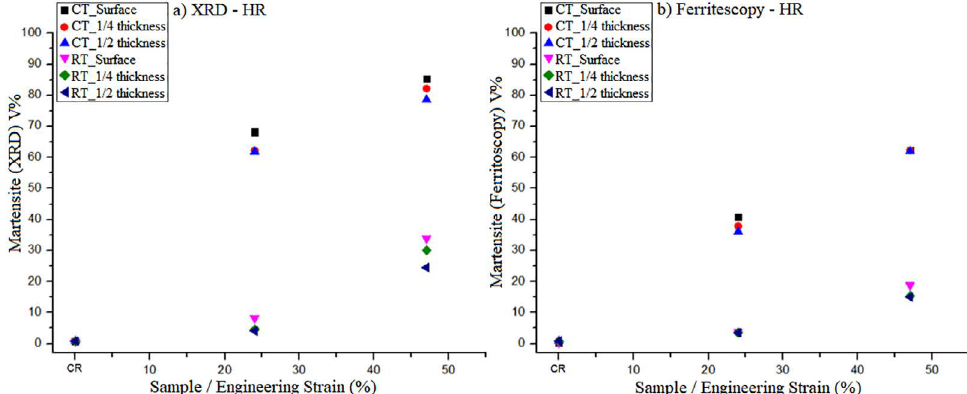
Figure 3. Induced martensitic transformation by tensile test at 298 K (RT) 155 K (CT) in HR